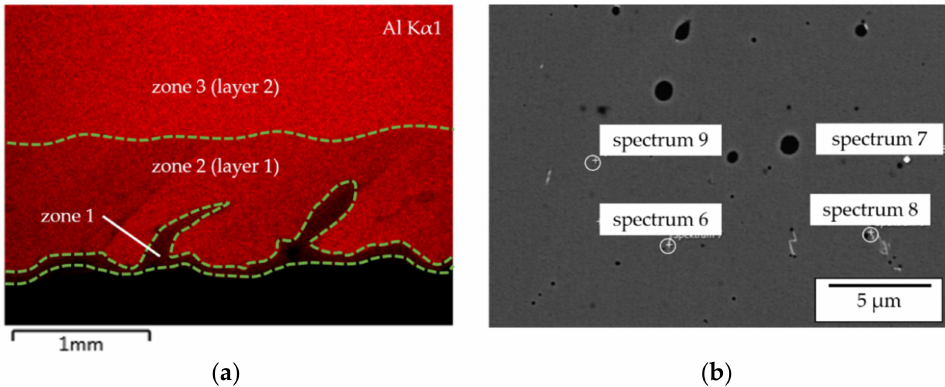
Figure 21. ( a ) EDX mapping of the Al distribution within the transition zone; ( b ) EDX analysis of Zr-rich precipitates within the deposited